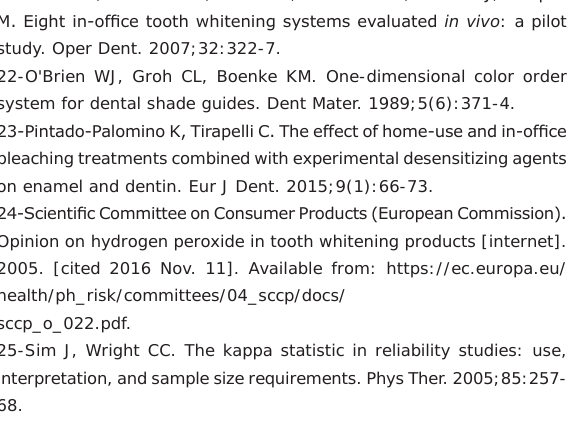
HM. Comparative tooth whitening and extrinsic tooth stain